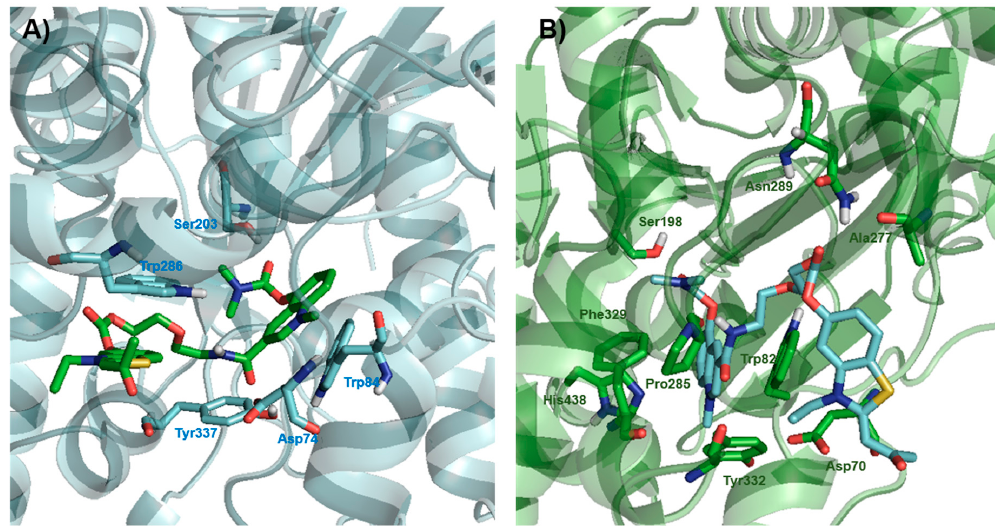
Figure 2. Top-scored pose obtained with Autodock Vina [52] for compound 14 positioned in ( A ) the active site of rh AChE (PDB ID: 4EY7), and ( B ) the active site of h BuChE (PDB ID: 1P0I). The compound and the selected side chains of the binding site residues are in stick and the protein in cartoon representation. This figure was made with PyMol [53].